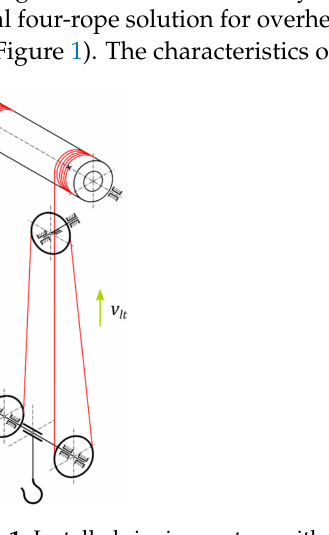
Figure 1. Installed rigging system with equalizing